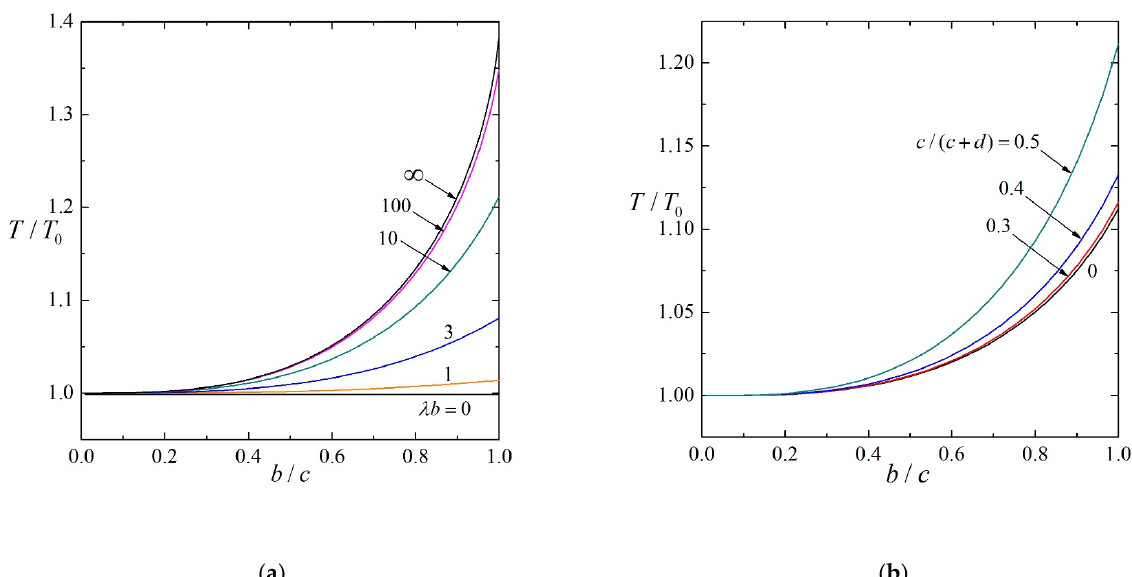
Figure 3. Normalized torque T / T 0 for a porous sphere ( a = 0) rotating about a diameter perpendicu- lar to two planar walls vs. the spacing parameter b / c : ( a ) c / ( c + d ) = 1/2; ( b ) λ b = 10.